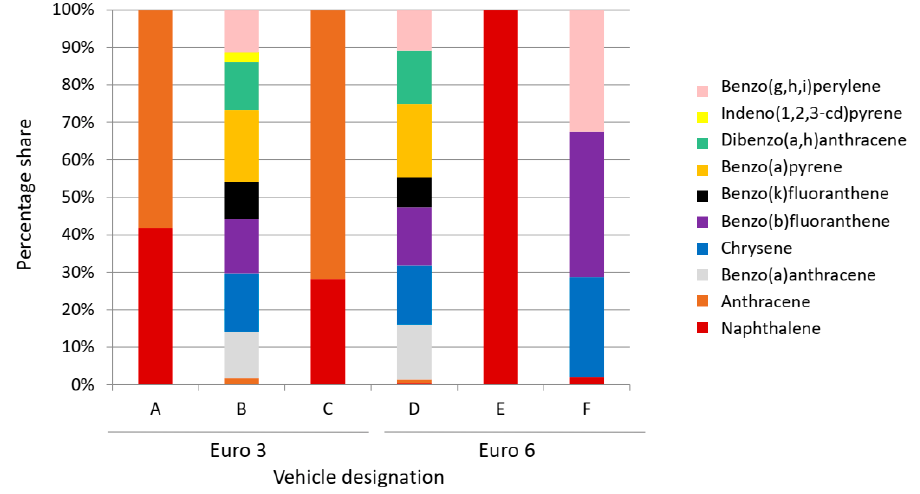
Figure 5. Qualitative assessment of the PAH group